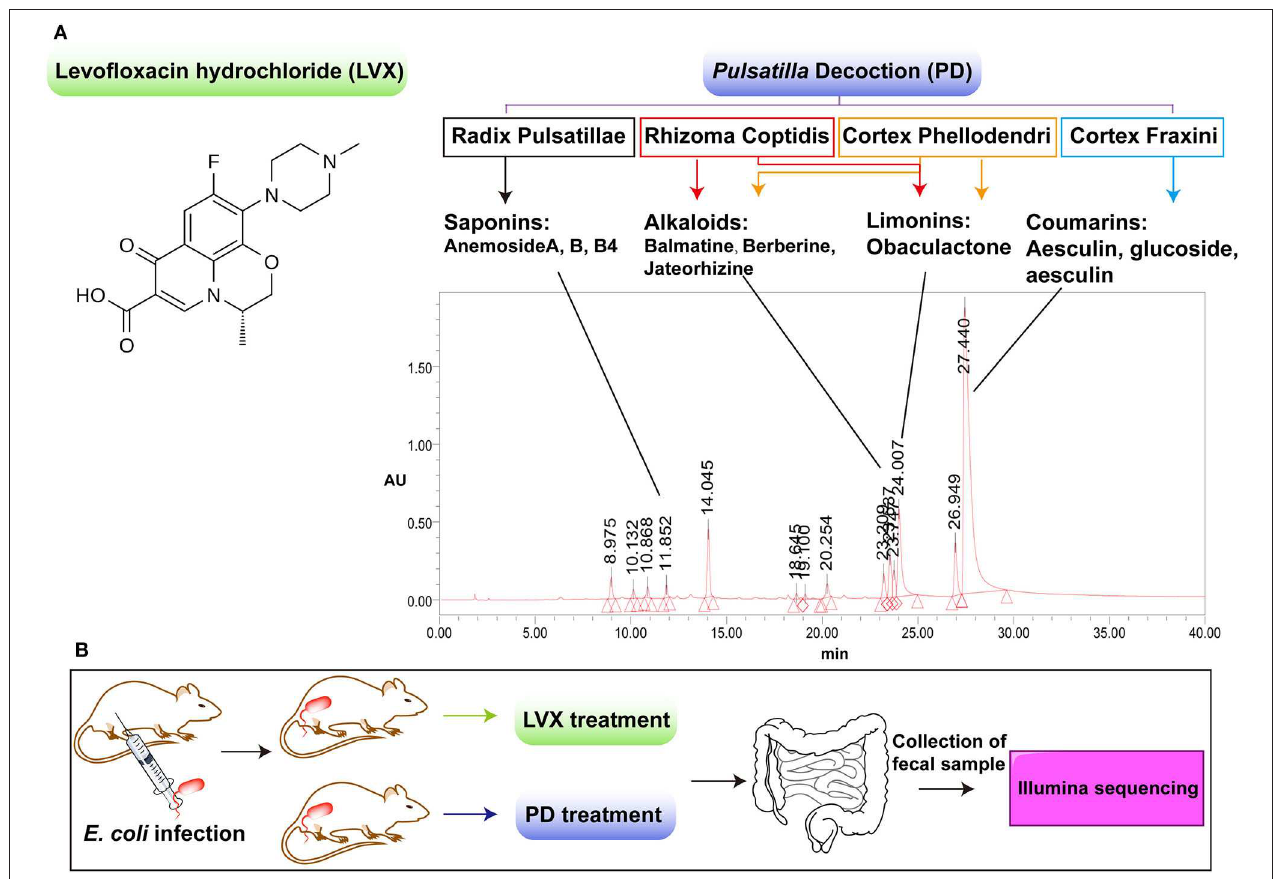
FIGURE 1 | Comparison of the chemical components between Levofloxacin hydrochloride (LVX) and Pulsatilla Decoction (PD). (A) LVX belonged to one kind of quinolone antibiotics, while PD was composed by four classical herbal formula, including radix Pulsatillae , Rhizome coptidis , Cortex phellodendri , Cortex fraxini . The main components of PD were analyzed by LC-MS/MS analysis. (B) Scheme of LVX and PD treatment on E. coli infected